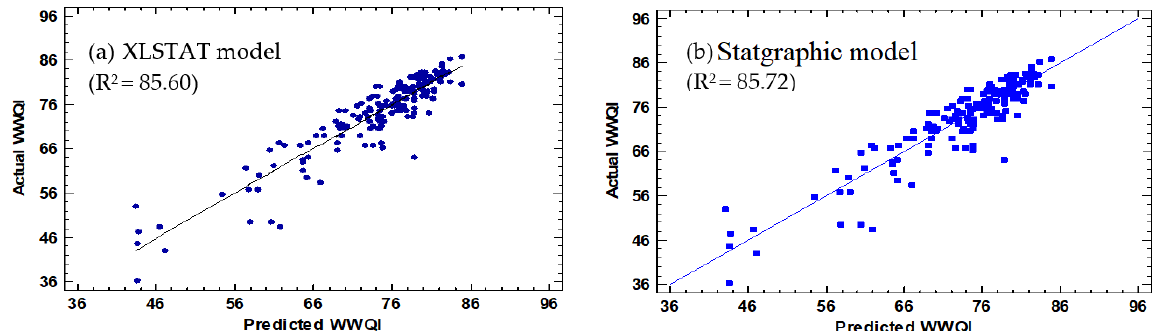
Figure 7. Comparison of the model for the measured and predicted value for the WWQI model; ( a ) XLSTAT analysis and ( b ) Statgraphic analysis.